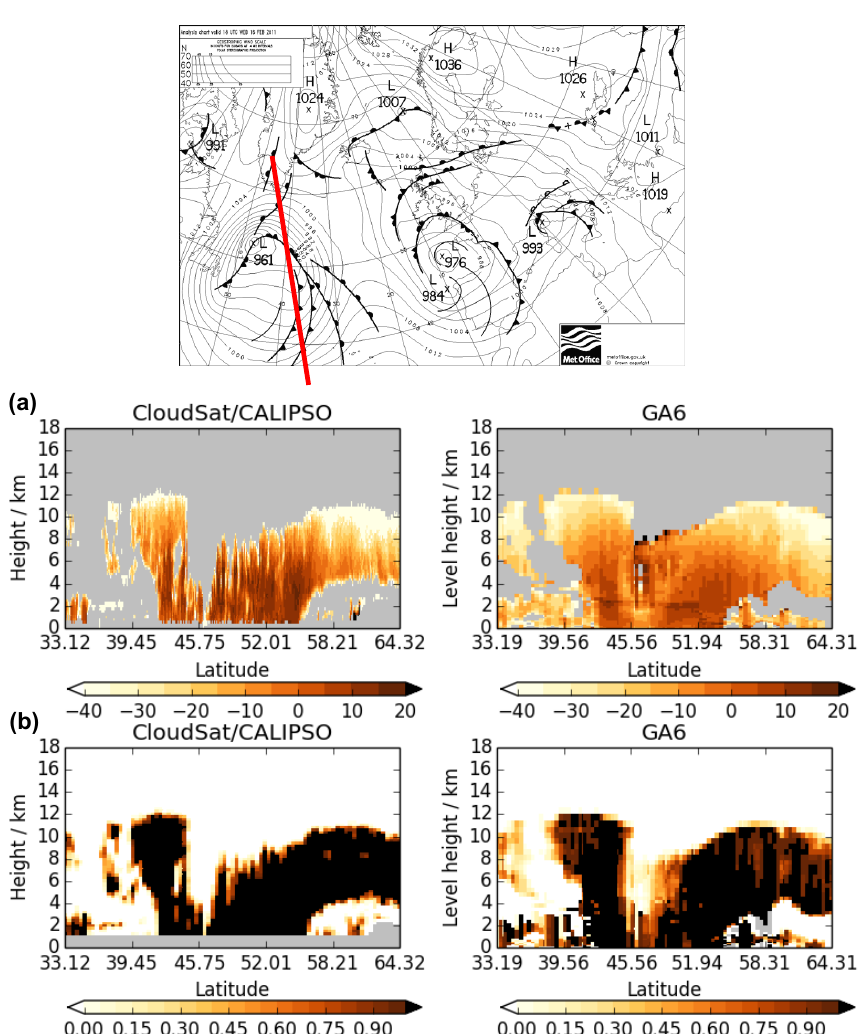
Figure 8. Case study of a GA6 27h forecast verifying at 15:00UTC on 16 February 2011 for an A-train pass over the North Atlantic, as shown by the red line on the synoptic analysis. (a) The observed and simulated radar reflectivities (dBZ) with situations in which the lidar detected cloud but the radar did not being included with a nominal value of − 40dBZ. (b) Observed and simulated cloud fraction on the model horizontal